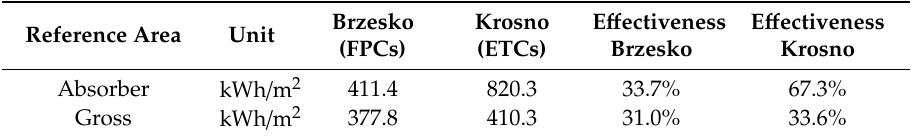
Table 4. Effectiveness calculated for insolation in the horizontal plane (Łęki) and solar heat gain values coming from installations in Brzesko and Krosno obtained in the period from 1 June 2014 to 31 July 2015.